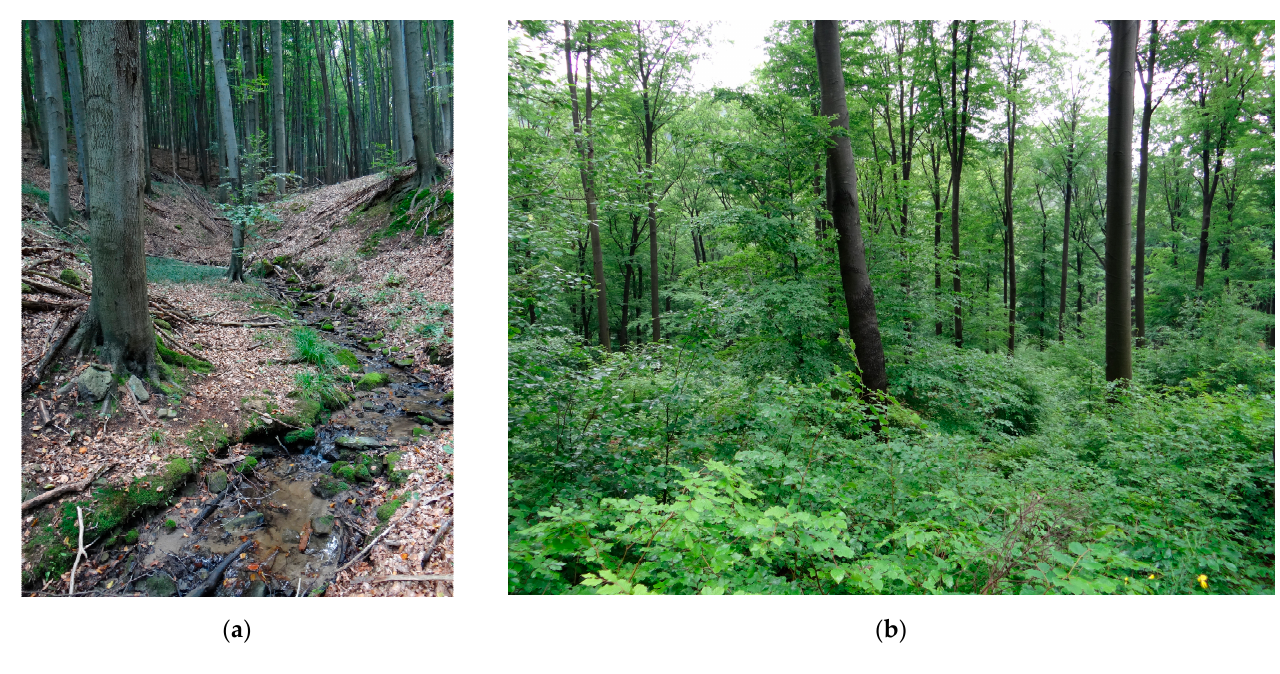
Figure 5. Forest stand type with dominancy of Fagus sylvatica, forest management unit 456: ( a ) detail of stand structure; ( b ) regeneration of stands dominated by F. sylvatica using shelterwood.